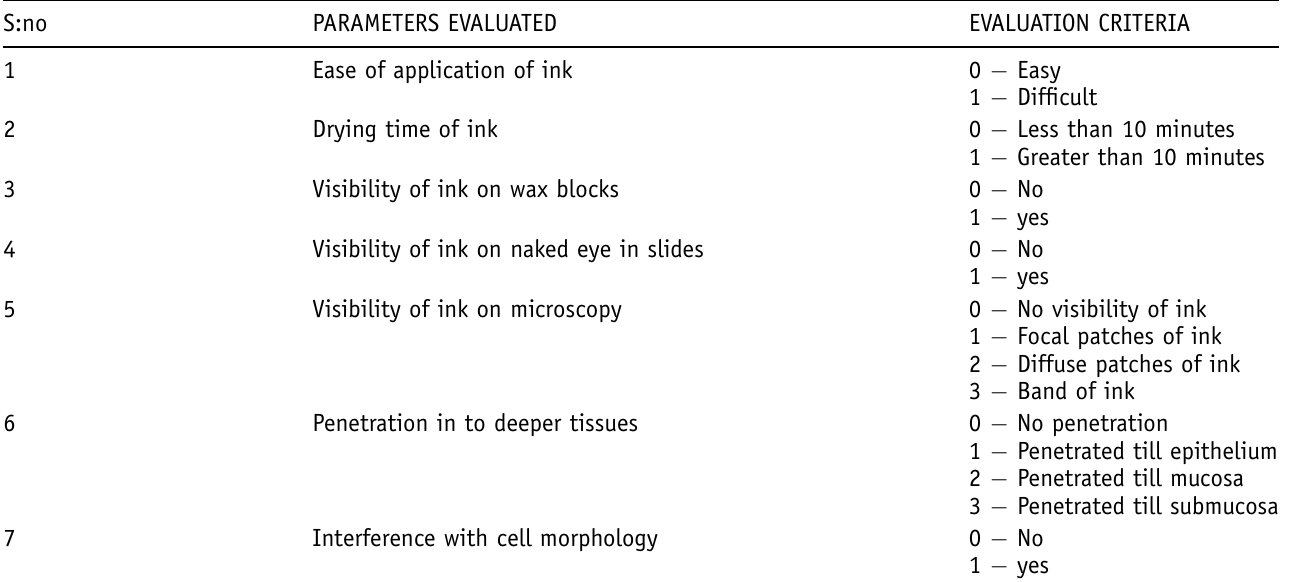
Table I. Macroscopic and Microscopic scoring criteria for inking of surgical